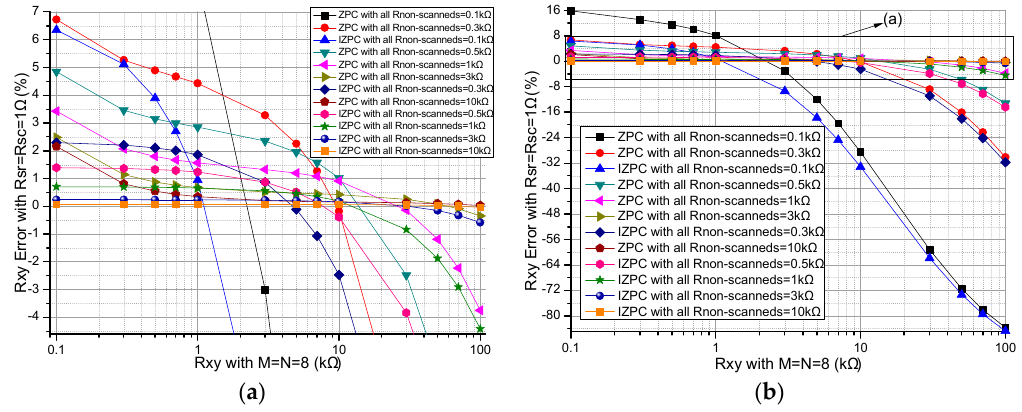
Figure 6. Effect of R non-scanned on the R xy errors of the basic circuit and those of the improved circuit: ( a ) the partial enlarged view; and ( b ) full view.